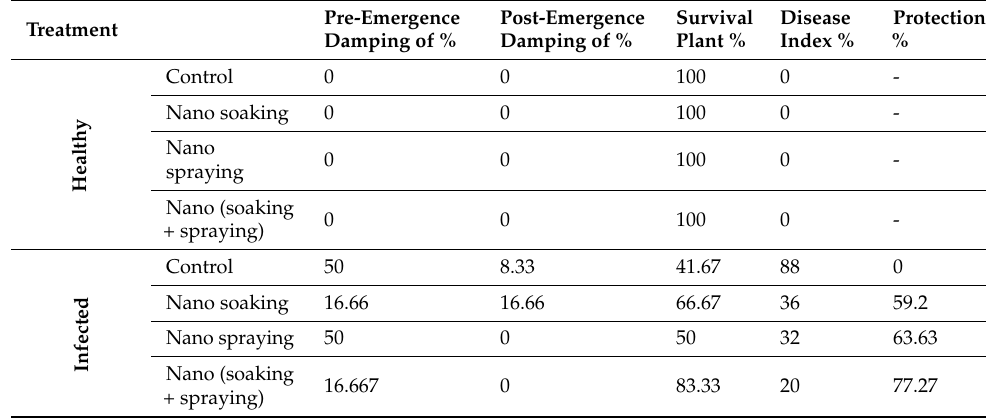
Figure 3. Effect of Se-NPs on R. solani ( A – C ): ( A ) Linear growth at different incubation periods from 0 to 7 days; ( B ) Inhibition percentages of R. solani at different concentration of Se-NPs; ( C ) Linear growth on potato dextrose agar medium (PDA) plates at 7 days. Data are expressed as means ± standard deviations of triplicate assays. The different alphabetic superscripts in the same column are significantly different ( p < 0.05) based on Tukey’s multiple comparison test. Table 2. Effect of selenium nanoparticles (Se-NPs) on the disease index of R. solani damping-off and root rot diseases under pot